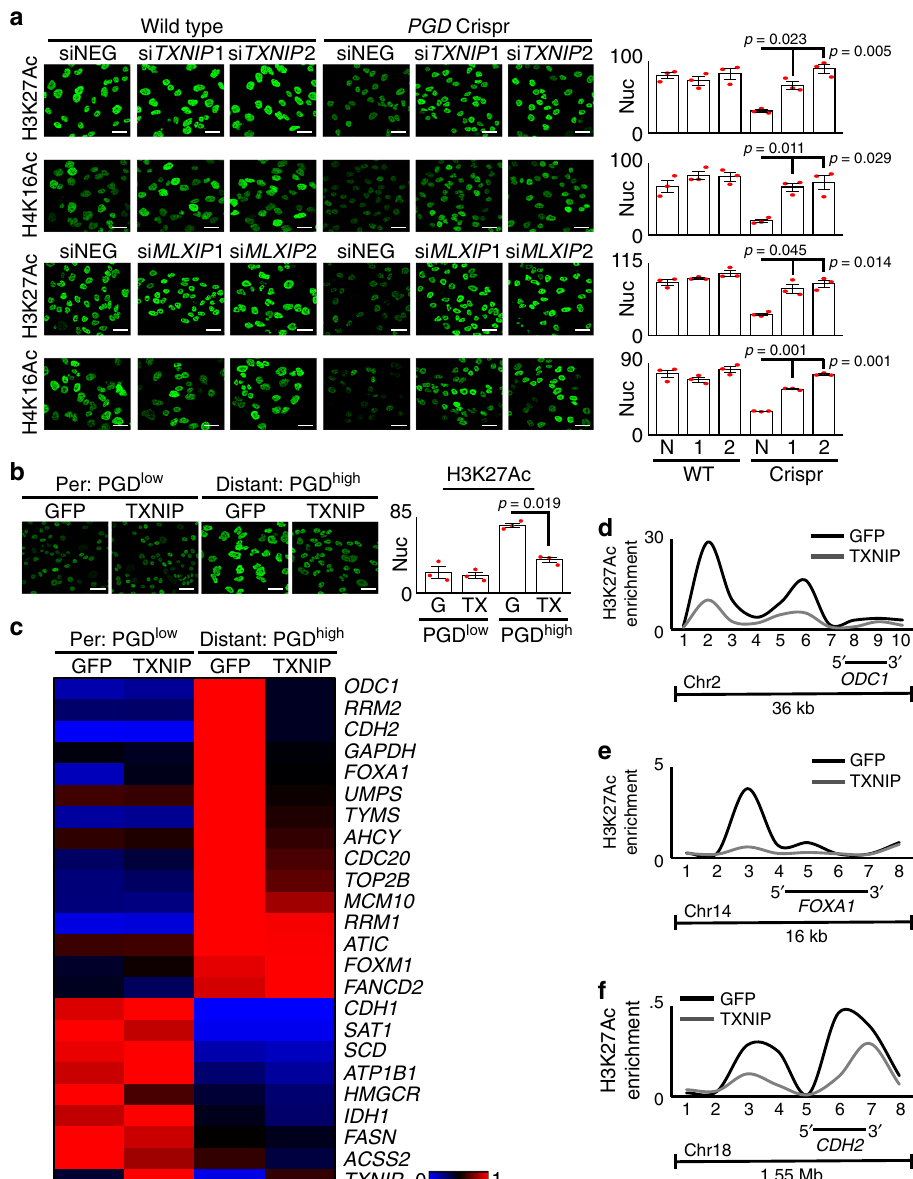
Fig. 6 PGD-driven suppression of TXNIP maintains hyperacetylated chromatin. a RNAi knockdown of either TXNIP (top two rows: si TXNIP 1, 2) or MondoA (bottom two rows: si MLXIP 1, 2) rescued loss of H3K27Ac and H4K16Ac in PGD high 38Lg cells during PGD inactivation (right three columns: PGD Crispr). b Expression of exogenous TXNIP in PGD high 38Lg cells (right two panels) reduced H3K27Ac to levels comparable with PGD low 38Per controls (left two panels). G, GFP; TX, TXNIP. c A heat map summarizing RT-qPCR data shows that recurrently upregulated genes in PDAC distant metastases (top 15, red/hot under Distant: PGD high GFP) were downregulated in response to exogenous TXNIP in PGD high 38Lg cells. A control panel of other downregulated genes (bottom, blue/cold under Distant: PGD high GFP) were not reactivated ( n = 3 technical replicates, p values calculated by two-sided t tests are shown in Supplementary Fig. 9b and in the Source Data fi le). d – f Exogenous TXNIP also lowered high H3K27Ac enrichments across loci encoding ODC1 ( d ), FOXA1 ( e ), and CDH2 ( f ) genes in PGD high cells by native ChIP assays. The x -axis indicates primer locations relative to the chromosome locations depicted underneath each plot (data is representative of 2 biological replicates). For all IF experiments: green, antibody signal, n = 3 biological replicates, error bars: s.e.m., indicated p values calculated by two-tailed t tests, scale bars: 20 µ